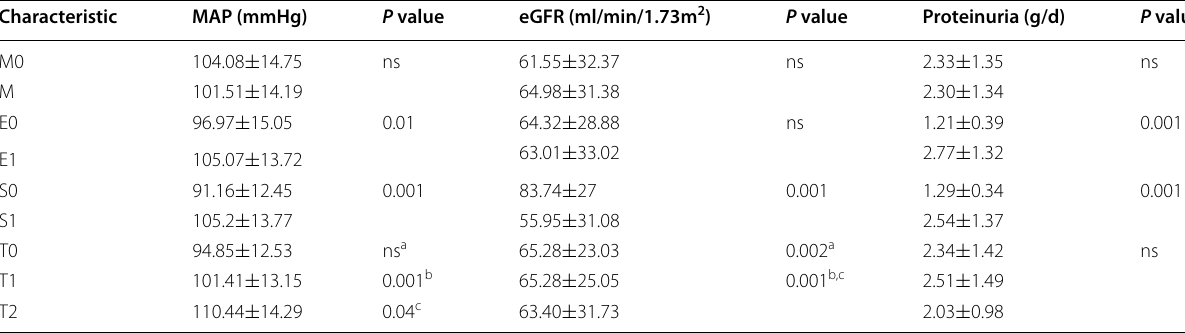
Table 4 Relationship between histopathological and clinical variables